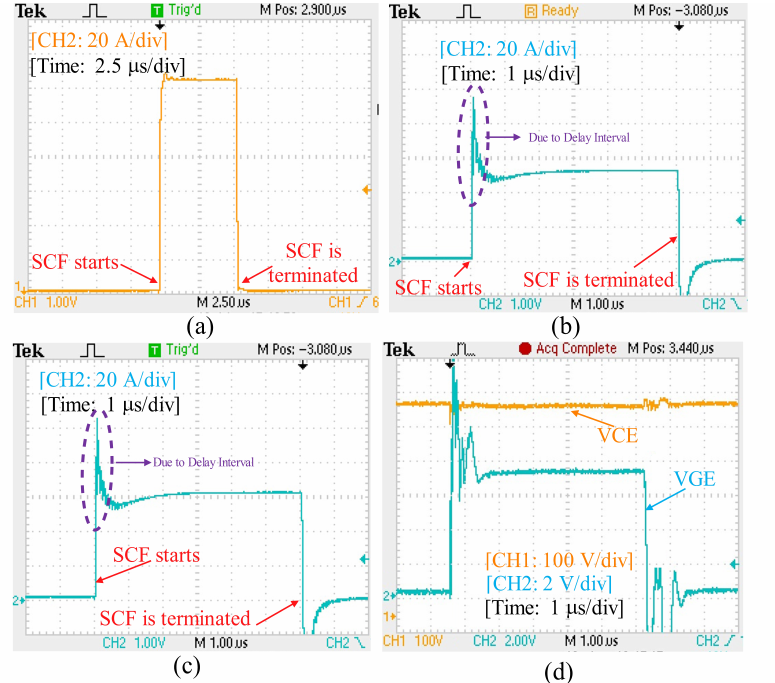
Figure 17. The experimental waveforms of ( a ) SCF current without applying the proposed method, ( b ) SCF current using the proposed method when SCF reference equals 50 A, ( c ) SCF current using the proposed method when SCF reference equals 65 A, and ( d ) gate-emitter and collector-emitter voltages of the IGBT.